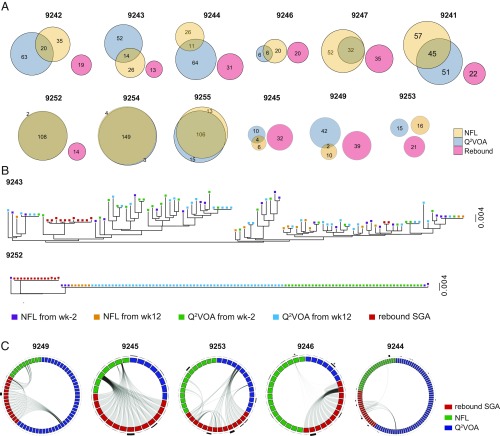
Comparisons of the circulating latent reservoir and rebound viruses. (A) Diagrams show the overlap between env sequences obtained from Q2VOA (blue), NFL sequencing (yellow), and rebound plasma SGA or PBMC outgrowth culture (red) (17). The intersection of the NFL and Q2VOA circles represents the number of identical env sequences belonging to clones obtained by both methods. Sequences obtained from the preinfusion and week 12 were combined. (B) Maximum likelihood phylogenetic trees of env sequences obtained from Q2VOA at preinfusion (green) and week 12 (blue), NFL at the preinfusion (purple) and week 12 (orange), and rebound viruses from SGA or outgrowth cultures (red) from two representative participants. Additional participants are shown in SI Appendix, Fig. S4. (C) Circos plots depicting recombination events between env sequences derived from Q2VOA at preinfusion (blue), intact NFL at preinfusion (green), and rebound plasma SGA (red). Gray lines show the contribution of parent sequences to recombinant sequences. Clonal env sequences were collapsed and represented as one virus. The thickness of the black outer bars represents the number of sequences obtained from that particular clone. Asterisks indicate the same env sequences between intact NFL and Q2VOA sequences.